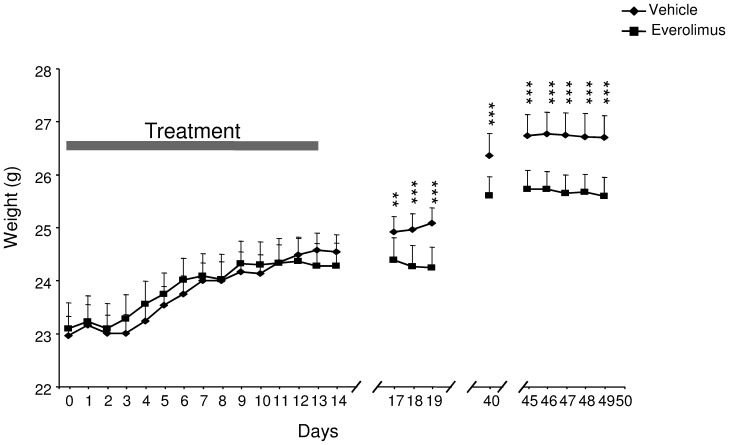
Impact of everolimus treatment on the mean body weight of mice.Body weight of vehicle- and everolimus-treated mice was evaluated at long term after the end of the treatment period (gray bar). Mice received vehicle or everolimus once a day during 14 continuous days. Bars represent standard error of the mean. ANOVA, Treatment x Day interaction p<.001 followed by LSD post hoc: **p<.01, ***p<.001.